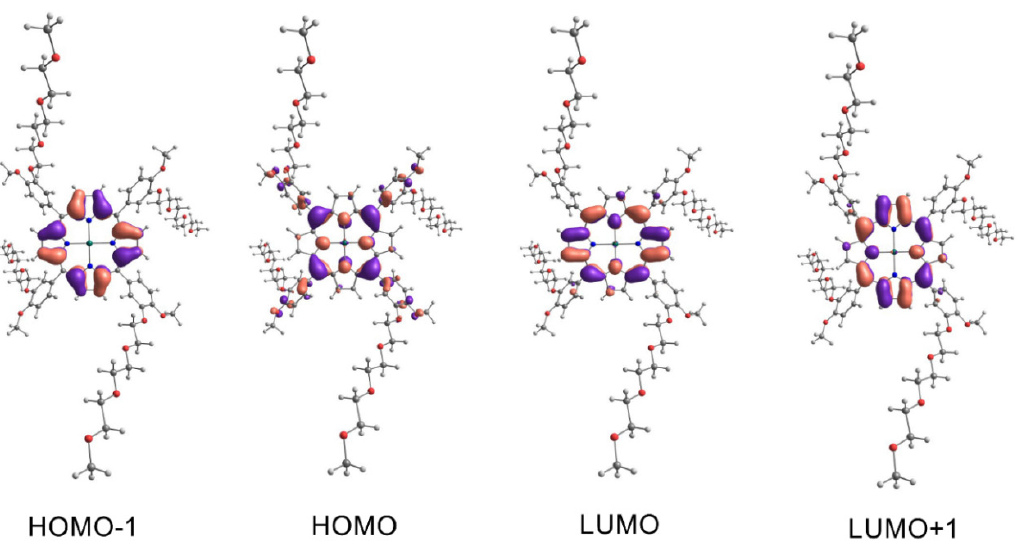
Figure 7. The molecular orbitals involved as the main component in the electronic transitions of 5 . Spatial functions representing orbitals were computed by application of PCM/TD-DFT/PBE1PBE/6- 31+G(d,p)//PBE1PBE/6-31G(d,p) with a contour value 0.03 a.u. The isosurfaces marked by violet and salmon colors represent parts of orbitals in different phases.